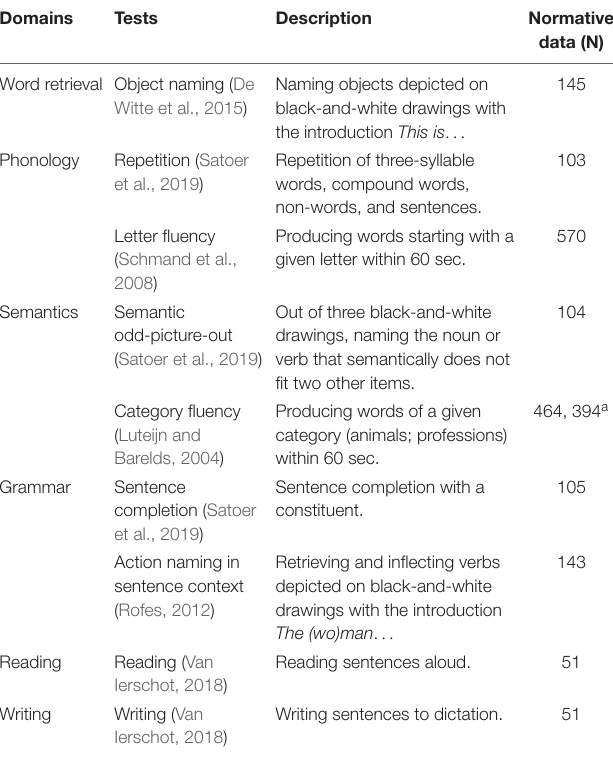
TABLE 1 | Language domains under investigation with their corresponding tests.